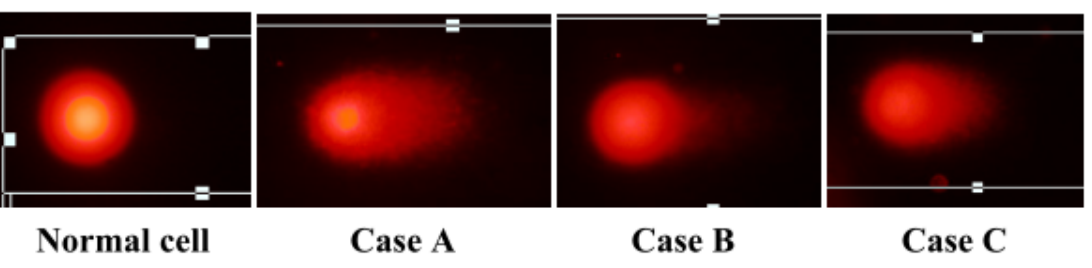
Figure 3. Comet images of lymphocytes from the three cases. The slides were stained with ethidium bromide, and the images were collected using a fluorescence